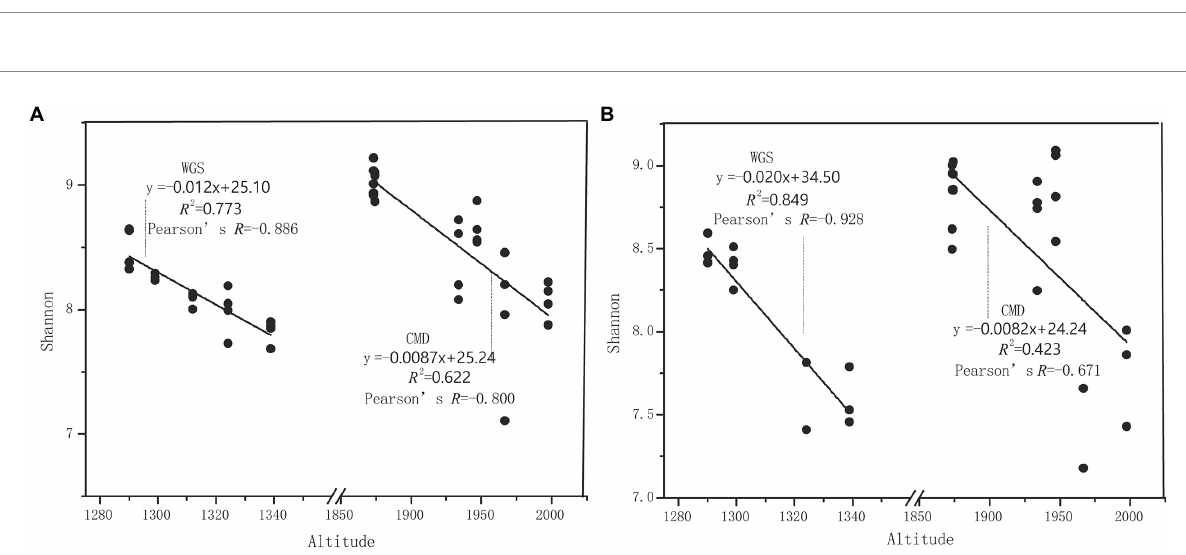
FIGURE 3 The relationships between altitudinal gradients and Shannon indexes in karst graben basin of Yunnan-Kweichow Plateau (A) indicating A layer and (B) indicating B